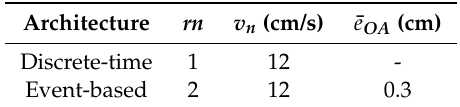
Table 1. Experiment 1: obstacles avoidance algorithm.